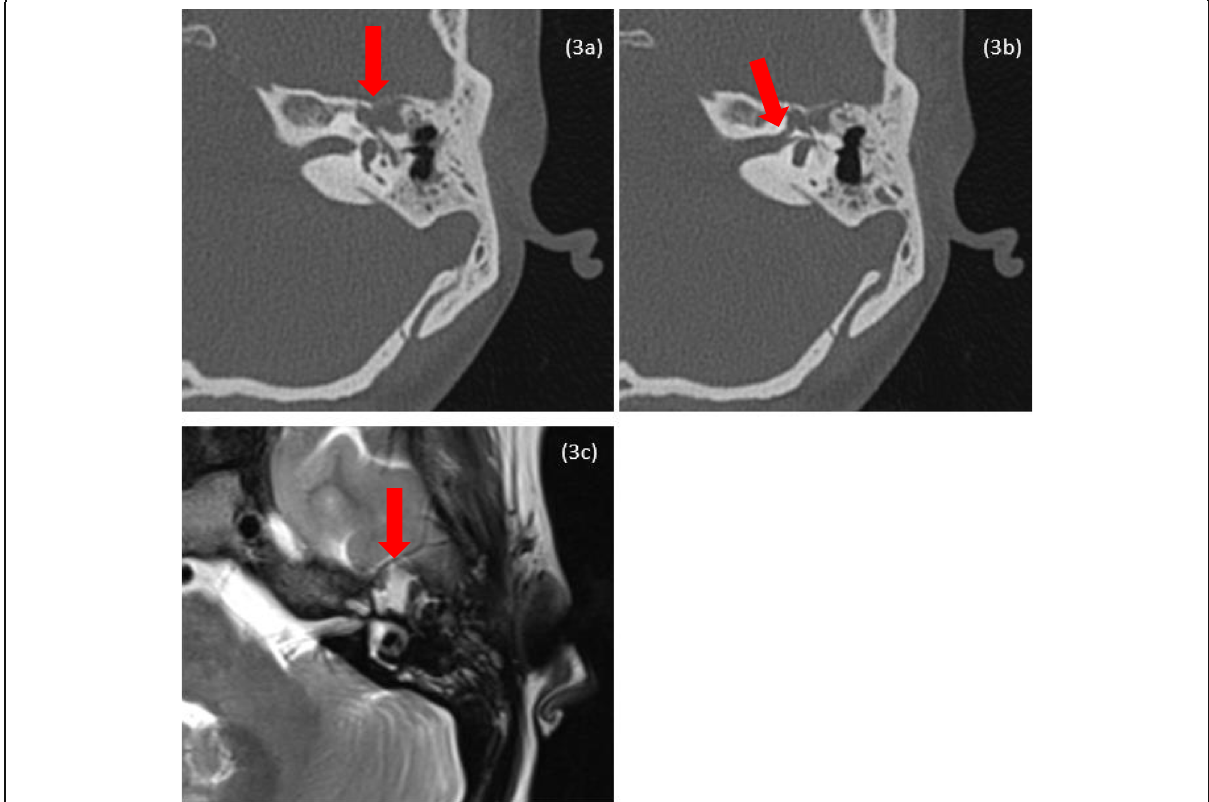
Fig. 3 a Axial cut of HRCT of temporal bone showing soft tissue density within the left middle ear cavity, causing displacement of normal ossicular configuration. The geniculate ganglion bony canal as well as the tympanic segment of facial canal appeared dehiscent. b The labyrinthine segment of the facial nerve appeared slightly widened. c Axial cut of MRI images depicting an abnormal signal intensity within the left middle ear cavity which appeared hypointense on T1-weighted, hyperintense on T2-weighted with minimal peripheral enhancement post- gadolinium suggesting co-existence of cholesterol